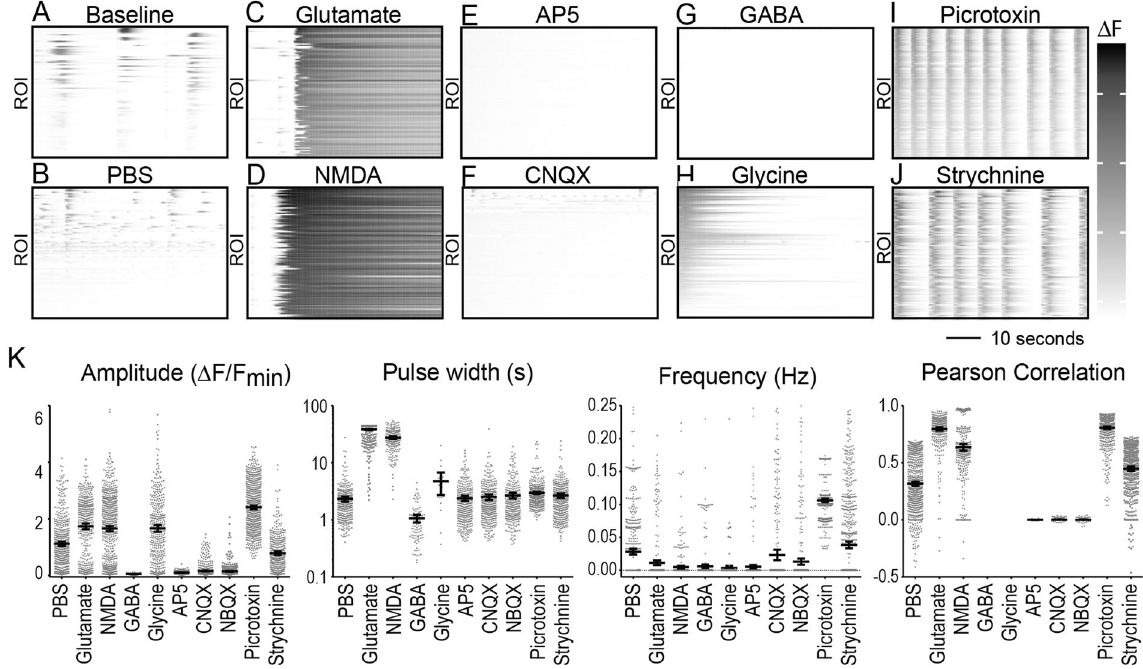
Figure 4. Waveform perturbation by receptor agonists and antagonists. ( A ) DIV11 cortical neurons were ( A ) left untreated or acutely treated with ( B ) PBS, ( C ) glutamate (23 μ M), ( D ) NMDA (35 μ M), ( E ) AP5 (29 μ M), ( F ) CNQX (3 μ M), ( G ) GABA (27 μ M), ( H ) glycine (1.7 mM), ( I ) picrotoxin (2.4 μ M), or ( J ) strychnine (6.3 μ M). Representative raster plots show Δ fluorescence traces for each ROI within the optical field. Data are representative of 3–6 treatment replicates across two independent experiments. ( K ) Average amplitude, frequency, pulse width, and Pearson correlation coefficient are plotted. Error bars represent 95%